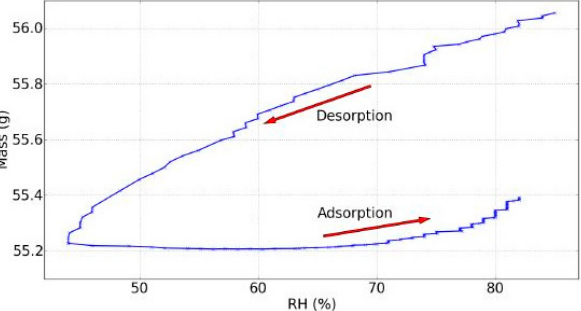
Figure 7. Dynamic sorption isotherm, day 7 of experiments.